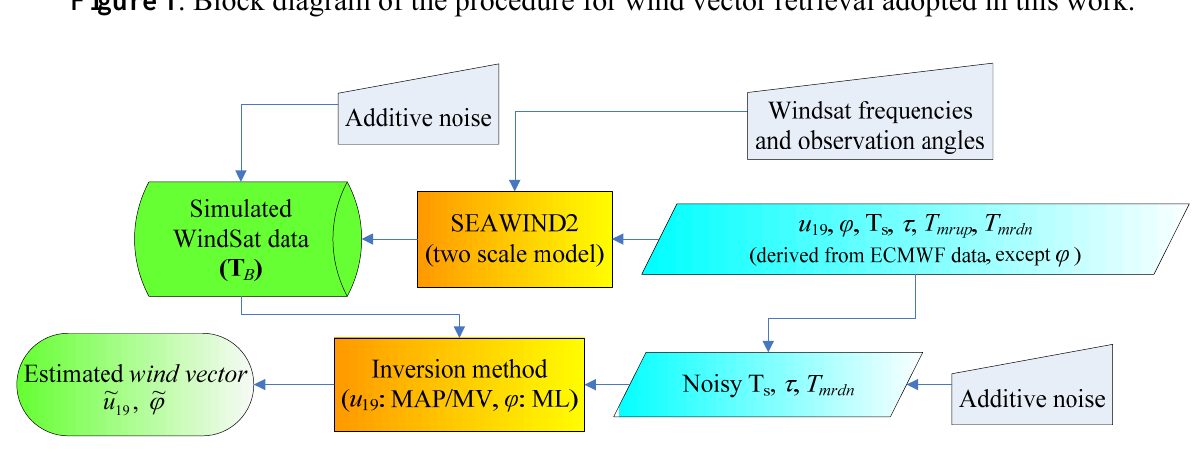
Figure 1 . Block diagram of the procedure for wind vector retrieval adopted in this